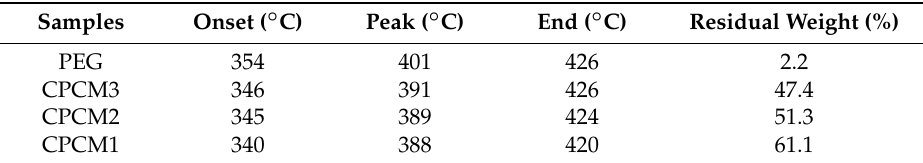
Table 1. TGA test results of PEG and CPCM3.